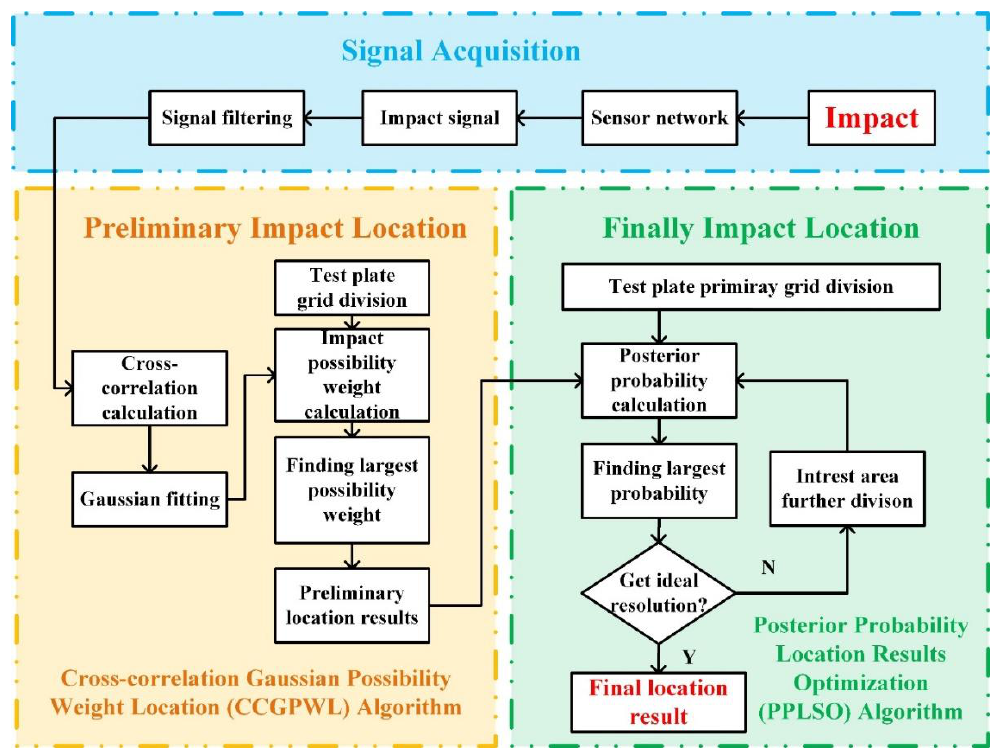
Figure 1. Flowchart of the posterior possibility weight correlation impact location (PPWCIL) algorithm.